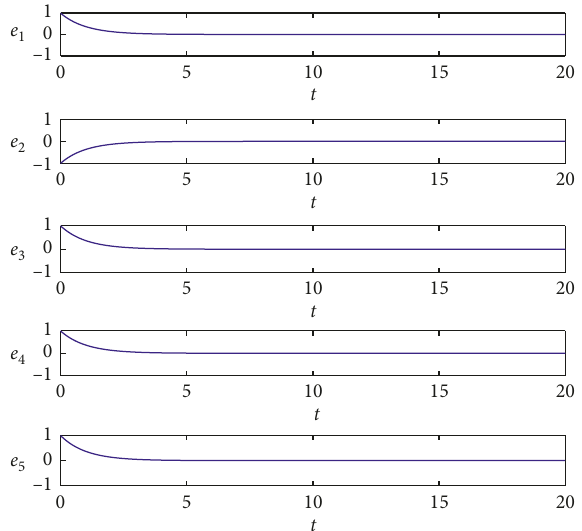
Figure 15: The trajectories of the synchronization errors ,e , e , e , and e e based on Matlab. 1 2 3 4 5